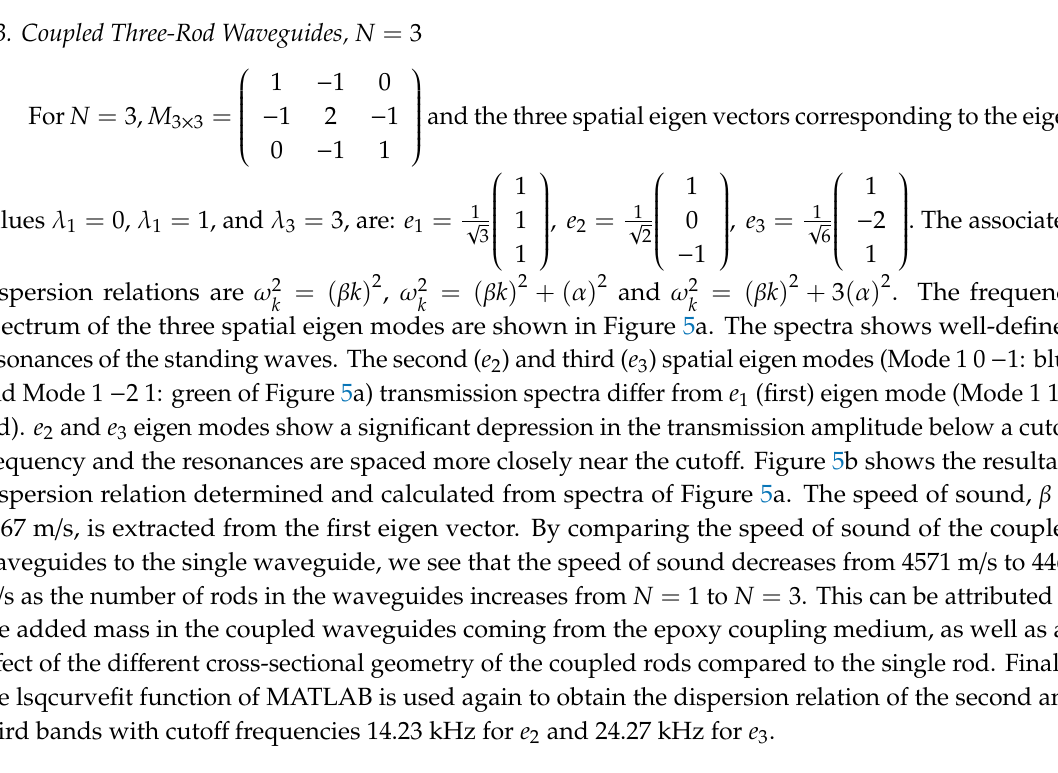
Figure 4. ( a ) Transmission spectrum of the two coupled rod system ( N = 2 ) for the two spatial eigen modes, namely the symmetric (1 1) mode and anti-symmetric (1 − 1) mode. The inset in ( a ) identifies the first two resonances of the symmetric mode and negligible transmission of the anti-symmetric mode at frequency < 10 kHz, identifying the first two resonances. The transmission amplitude is in arbitrary units. ( b ) Band structure determined and calculated from ( a ). The asterisks in ( b ) are obtained from the resonances of mode: 1 1 of ( a ) and the solid line associated with the asterisks is a fit to the low frequency resonances. The open circles in ( b ) correspond to resonant modes associated with the anti-symmetric spatial eigen mode and the solid line is a fit to these identifiable resonances using the dispersion relation with a cuto ff frequency of 20.24